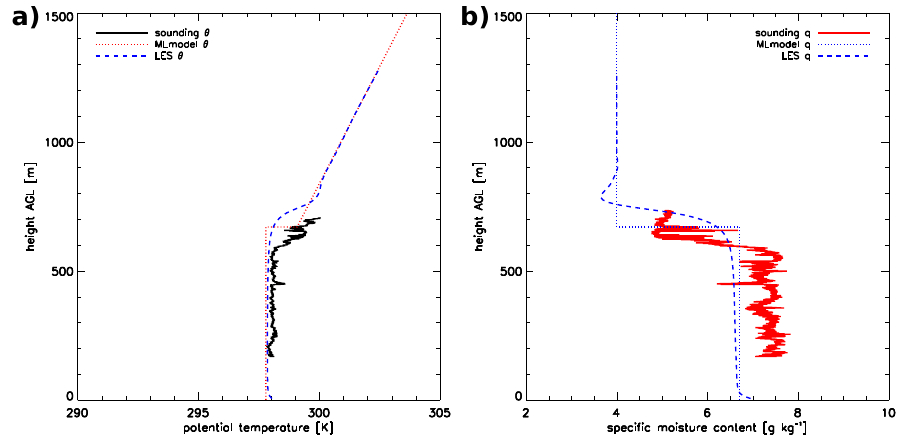
Figure 10. Vertical profile of (a) potential temperature ( θ ) and (b) specific humidity ( q ) at 16:50UTC: aircraft profiling, DALES and mixed- layer